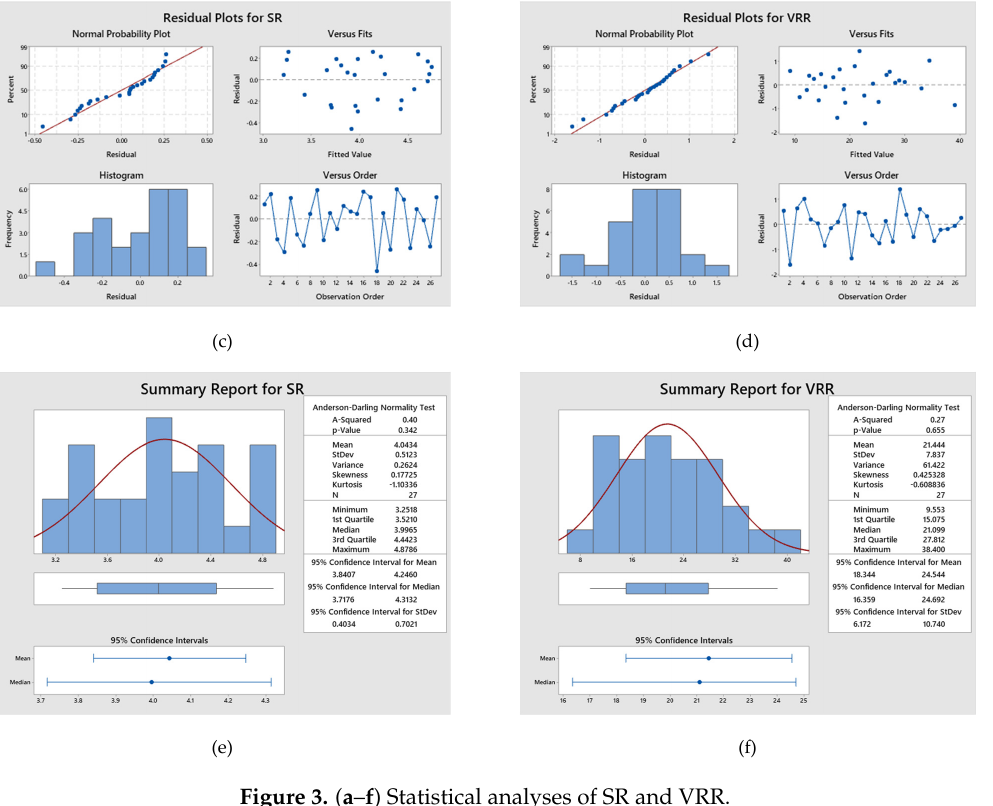
Figure 3. ( a – f ) Statistical analyses of SR and VRR.